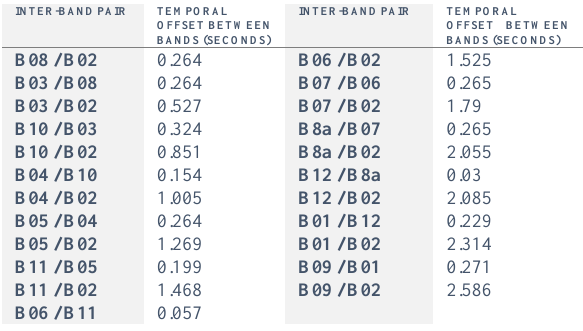
Table 2 : ESA time delay table as published in The Copernicus technical guide website.